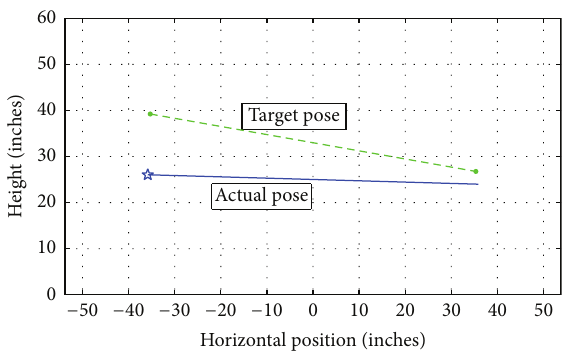
Figure 5: A screen shot of the real time display seen by the “leader,” depicting the current position of the board as well as the target